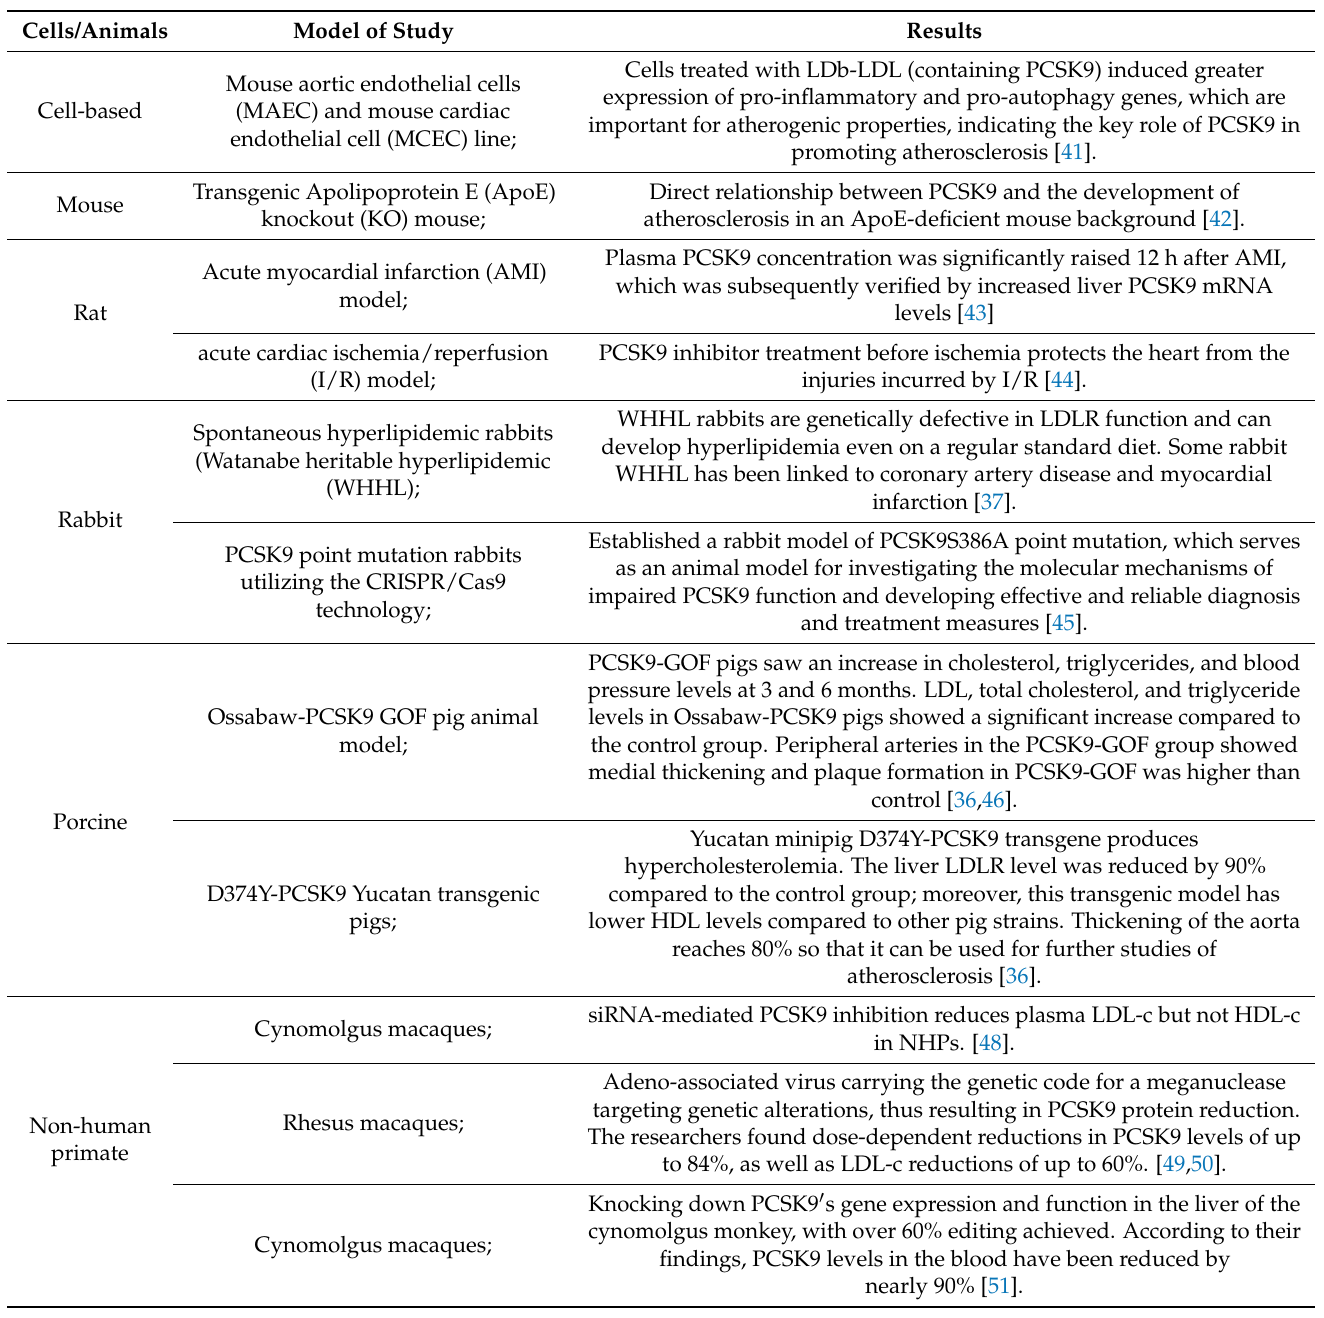
Table 2. The prospective animal model that can be used for future PCSK9-induced platelet activation in cardiovascular disease